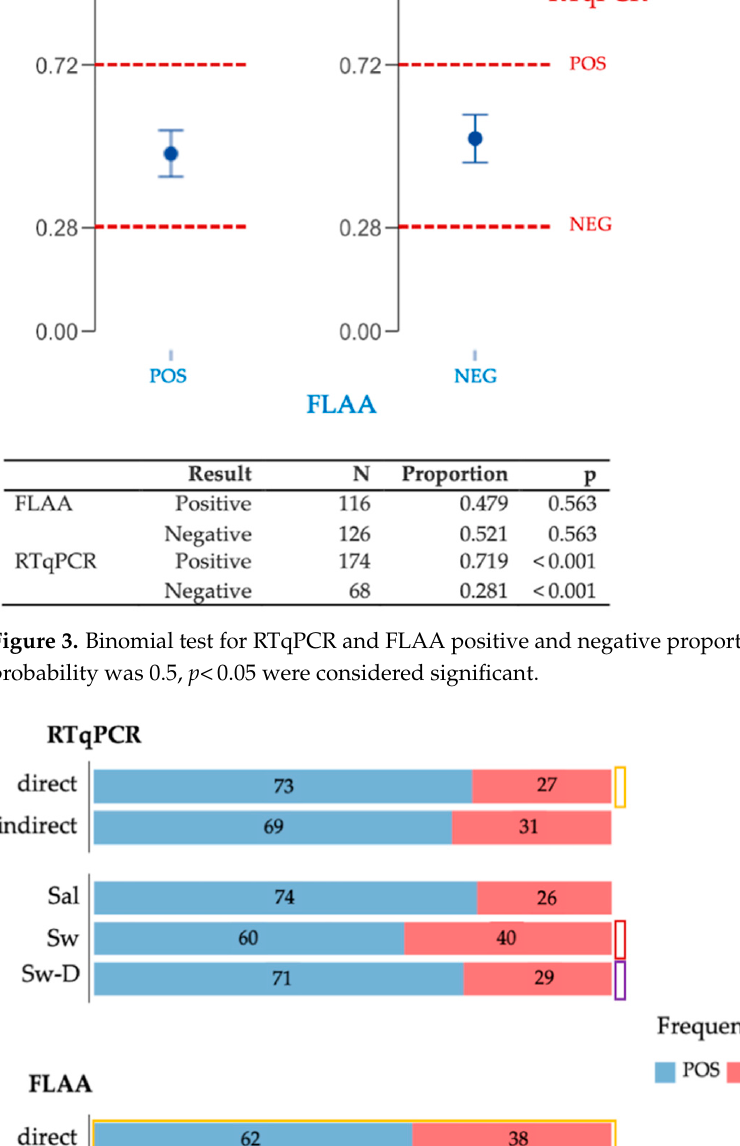
Figure 3. Binomial test for RTqPCR and FLAA positive and negative proportions. No discriminative probability was 0.5, p < 0.05 were considered significant.